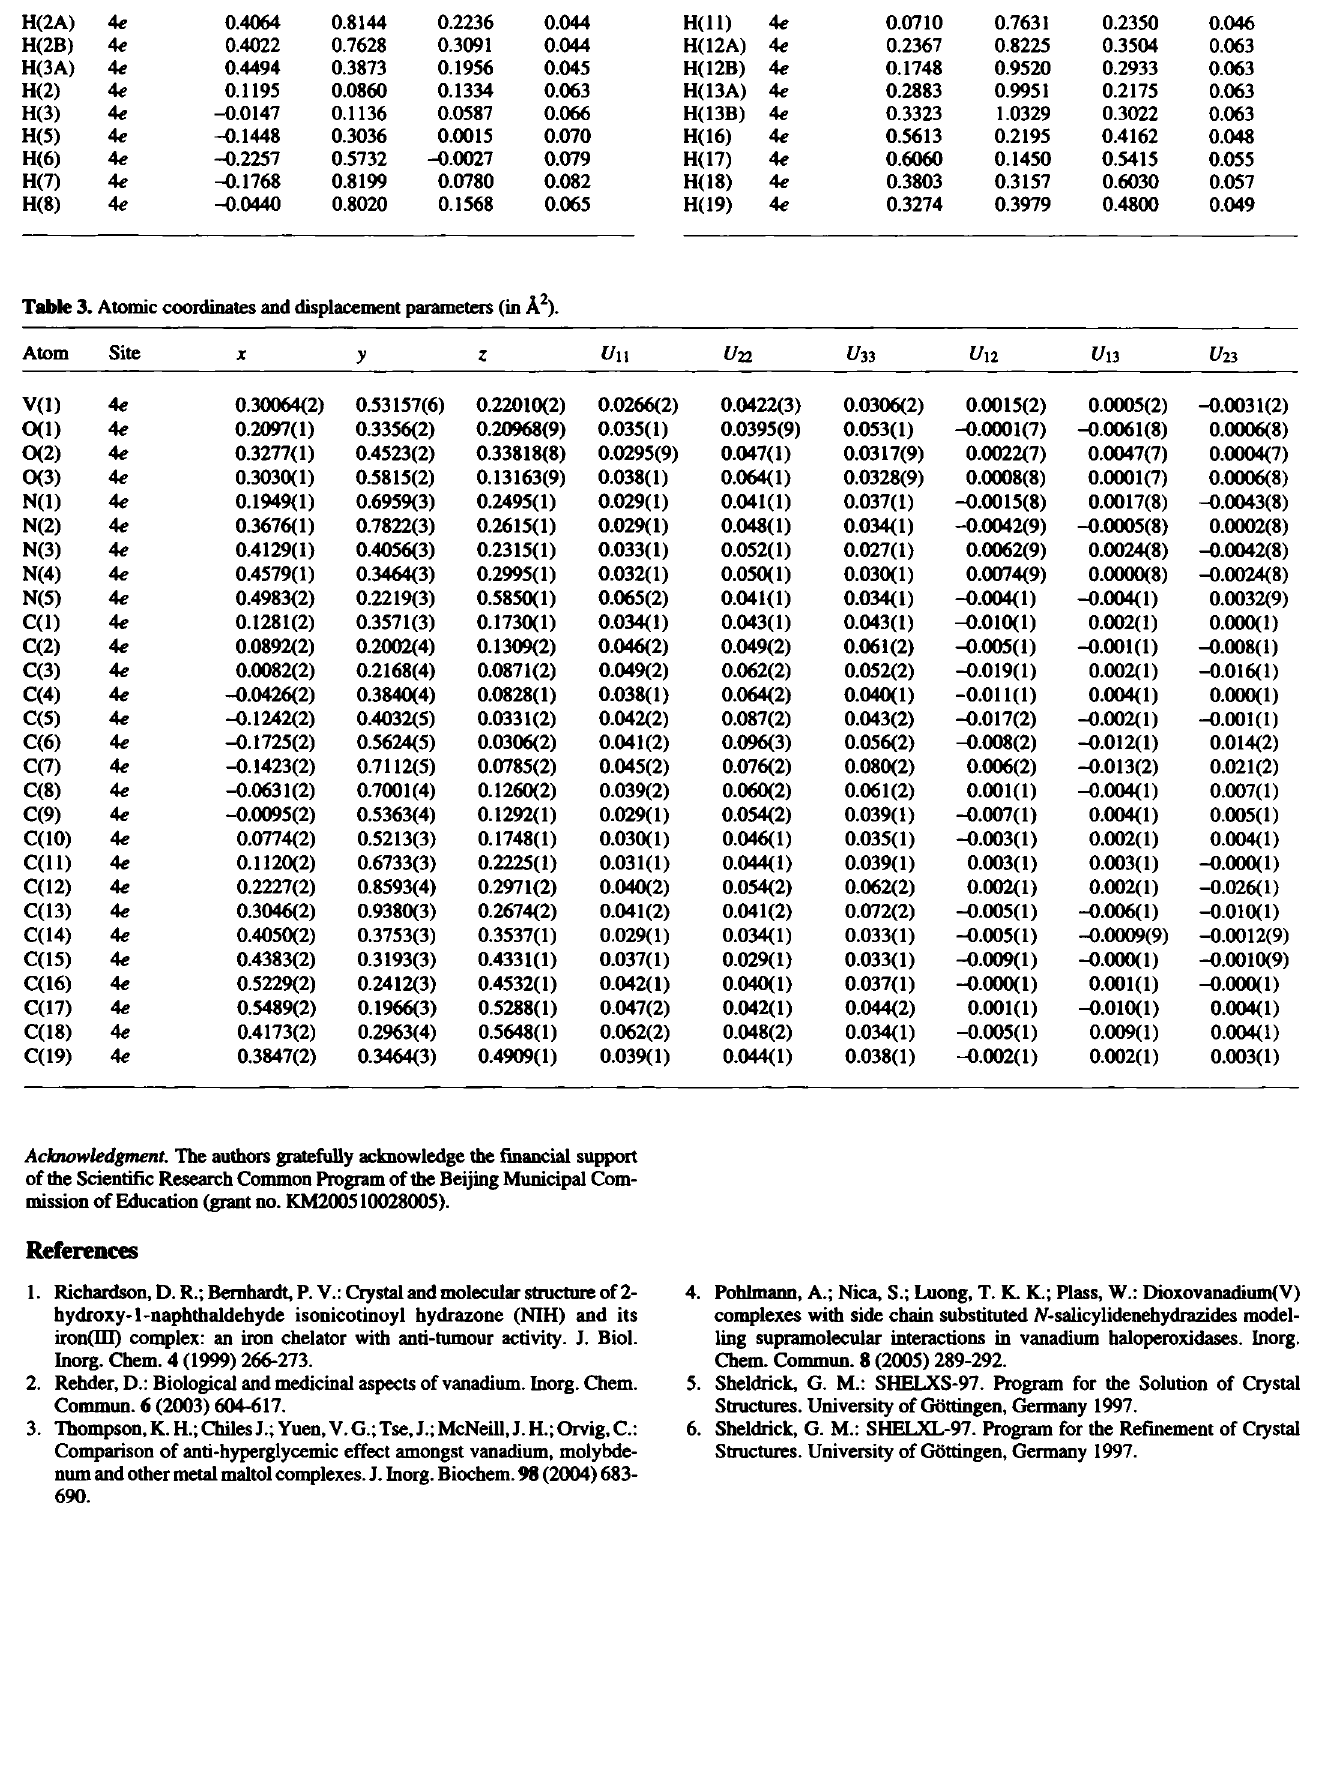
Table 3. Atomic coordinates and displacement parameters (in A 2